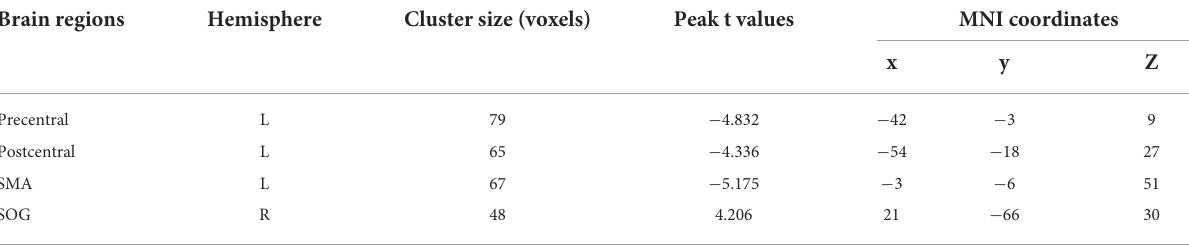
TABLE 3 Altered rsFC from the left mOFC to other brain regions in bulimia nervosa patients. Brain regions Hemisphere